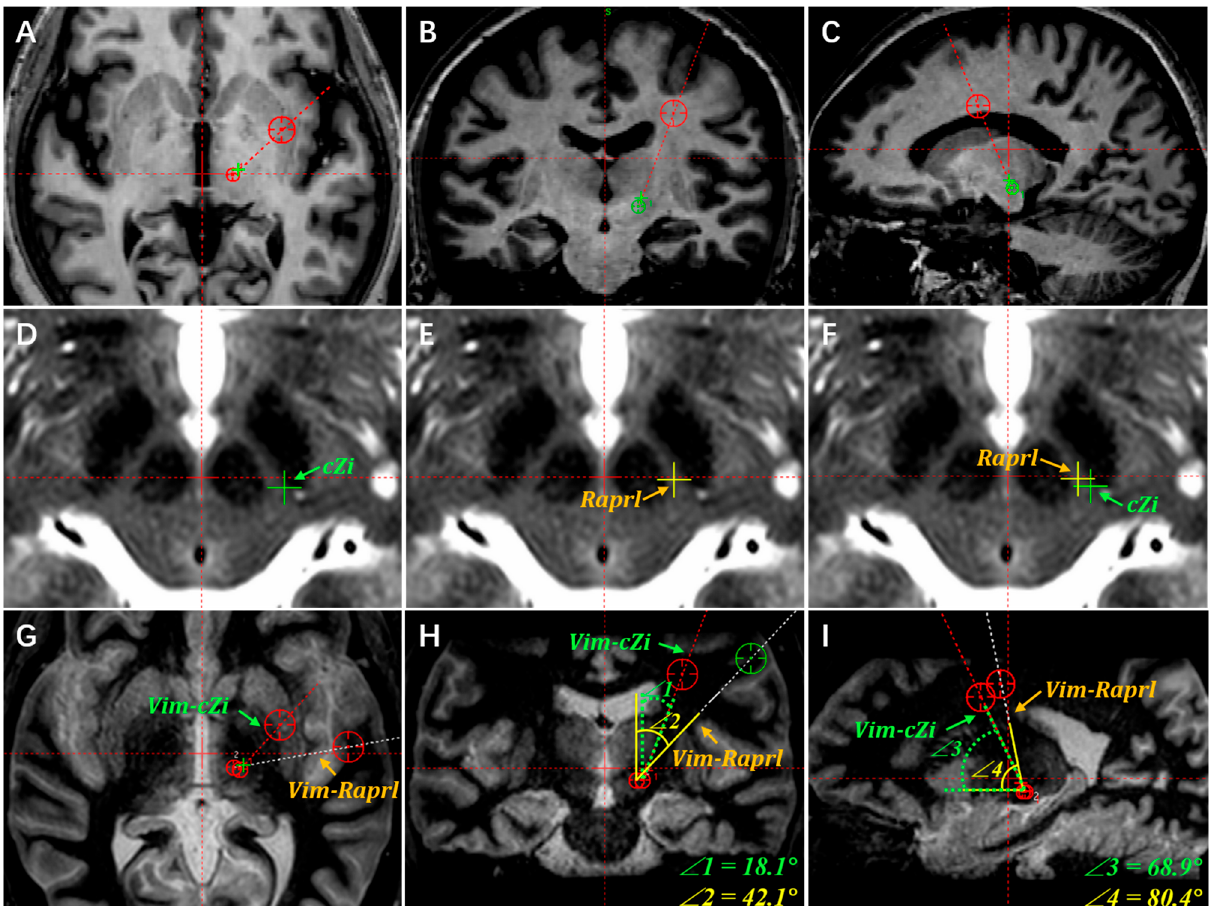
Figure 2. The cZi is selected as the preferred PSA region for alignment of the Vim and PSA. ( A ) The default coronal and sagittal angles of trajectory are usually preset on the axial plane. The coronal and sagittal angles are adjusted to ensure that the trajectory traverses the target of Vim on the coronal ( B ) and sagittal planes ( C ). ( D ) The cZi target is marked with a green “+” on the axial T2WI images. ( E ) The common stimulated area of Raprl for ET is marked with a yellow “+” on the T2WI images. ( F ) The Raprl target lies medial and anterior to the cZi on the same plane of the axial T2WI images. To illustrate the selection of the stimulation region in the PSA, the planned Vim–cZi and Vim–Raprl trajectories are compared on the axial ( G ), coronal ( H ), and sagittal ( I ) planes, respectively . In this case, the Vim stereotactic coordinates are 13.7 mm lateral, 5.6 mm posterior, and 1.0 mm inferior relative to the MCP. The cZi stereotactic coordinates are 12.5 mm lateral, 6.9 mm posterior, and 4.0 mm inferior relative to the MCP. As for the Raprl, the stereotactic coordinates are 10.6 mm lateral, 6.1 mm posterior, and 4.0 mm inferior relative to the MCP. Correspondingly, the coronal and sagittal angles of the Vim–cZi trajectory are, respectively, 18.1 degrees and 68.9 degrees ( ∠ 1 and ∠ 3 in Figure 2H,I). The coronal and sagittal angles of the Vim–Raprl trajectory are, respectively, 42.1 degrees and 80.4 degrees ( ∠ 2 and ∠ 4 in Figure 2H,I). Both the coronal and sagittal angles of the Vim–Raprl trajectory are significantly larger than those of the Vim–cZi trajectory. Meanwhile, the Vim–Raprl trajectory traverses the internal capsule and insular